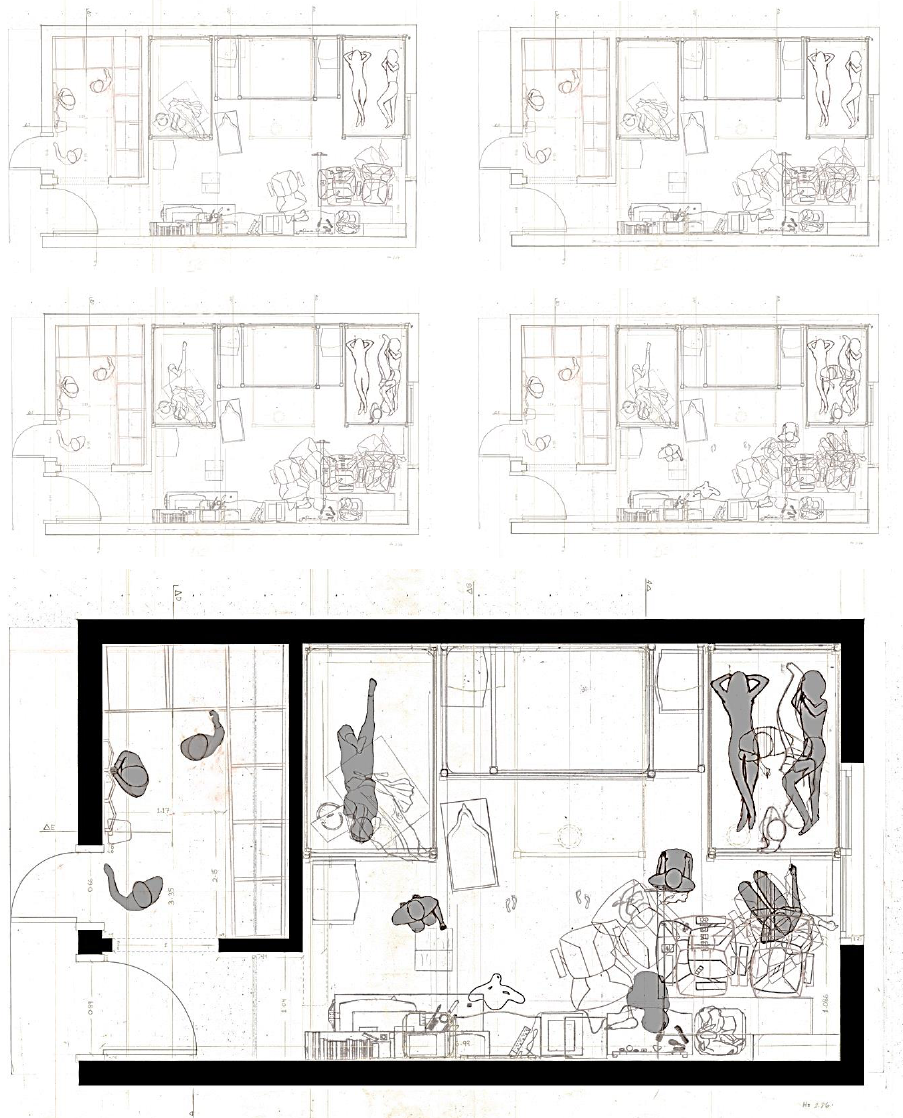
Figure 2. Plan orthographic drawing of the bedroom space, showing the five steps: periphery, fixed and movable elements, immateriality, zones of occupation and body movements; showing the layered level of investigated documentation and the final drawing outcome.